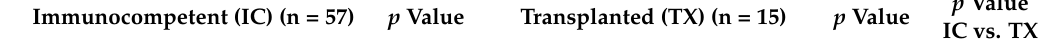
Table 1. Patient